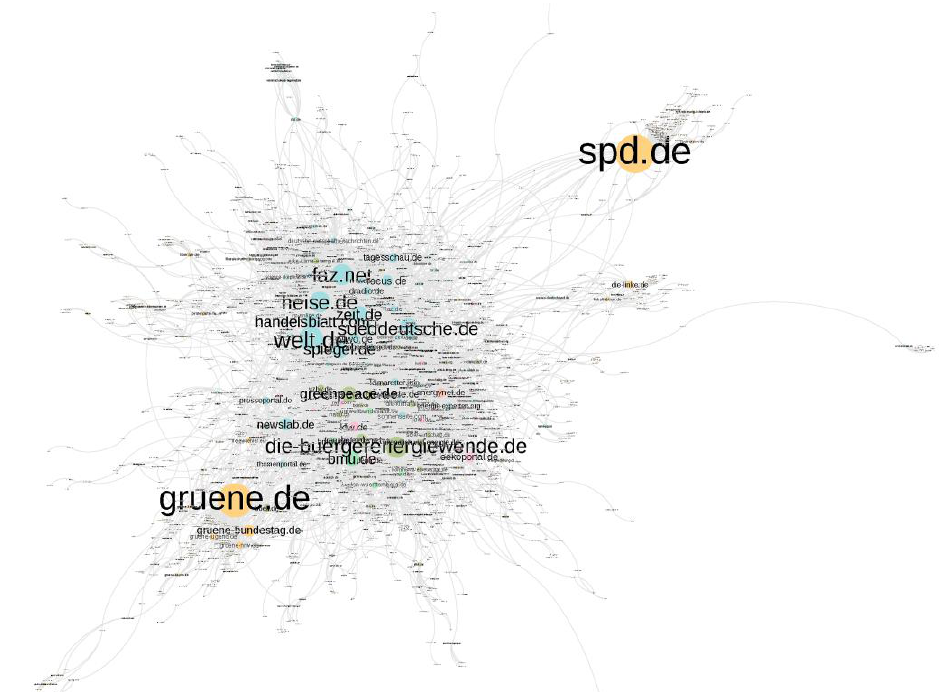
Figure 1. Hyperlink-Network of all domains (node size by indegree, node colour by coded societal field, layout algorithm: